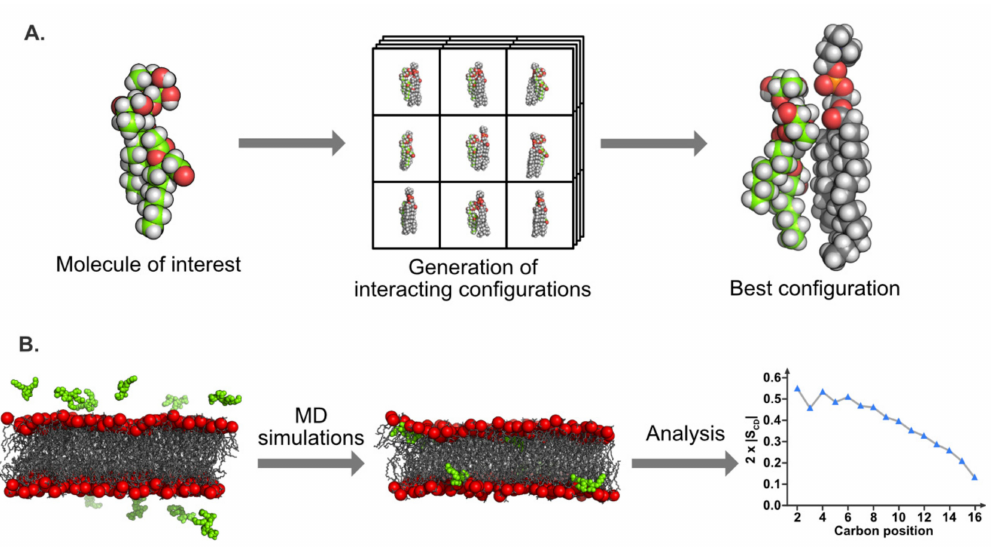
Figure 5. Examples of molecular modeling applied to amphiphilic molecule / membrane interactions. (Panel A ) shows the Hypermatrix procedure where the molecule of interest is used as a reference for the docking of a lipid molecule (left). Many configurations of the reference molecule in interaction with the docked lipid are generated by translation and rotation of the lipid (middle). Among all these configurations, the one with the lowest energy (i.e., the most stable) is considered to be the best candidate with which to characterize the molecule / lipid interaction (right). In panel A, the carbons of the molecule of interest are represented using green beads, whereas lipid carbons are gray. For both molecules, hydrogen, oxygen, and phosphorus atoms are represented in white, red, and orange, respectively. (Panel B ) shows a MD simulation of amphiphilic molecules (green beads) in interaction with a lipid membrane (chains as gray wires and head groups as red beads). At the beginning of the simulation (left), the molecules are located outside of the membrane (water is not represented for clarity). At the end of the simulation (middle), all the molecules are located inside the lipid bilayer. These qualitative results can be completed via quantitative analysis such the calculation of the order profile (right) that can then be compared with experimental